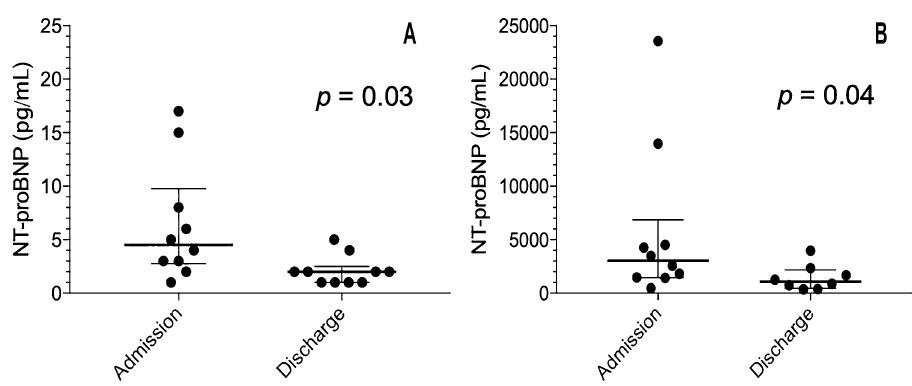
Figure 2. Box-plot for NT-proBNP measured in saliva ( A ) and in blood ( B ). The box-plot shows: the minimum, 25th percentile, median, 75th percentiles, and the maximum value for each variable. Outliers are shown with black points. For both saliva and blood, HF patients at discharge had significantly lower median NT-proBNP values than at